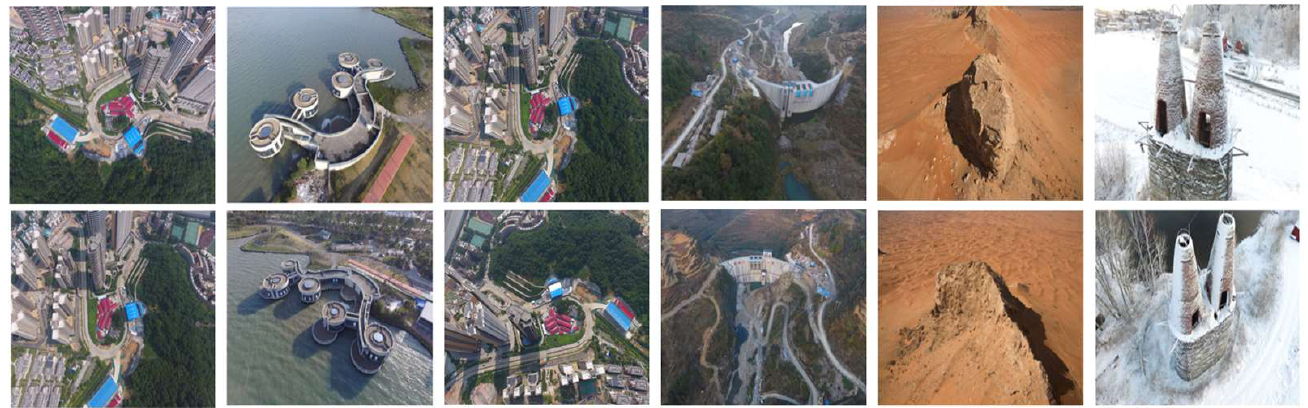
Figure 3. Sample image pairs of multi-level keypoints detector training data.